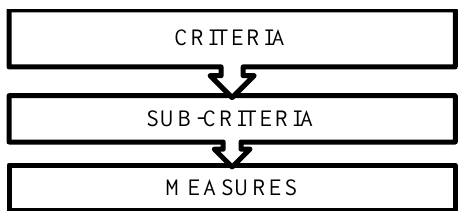
Figure 2. The proposed hierarchy for three-level structure as criteria, sub-criteria, and